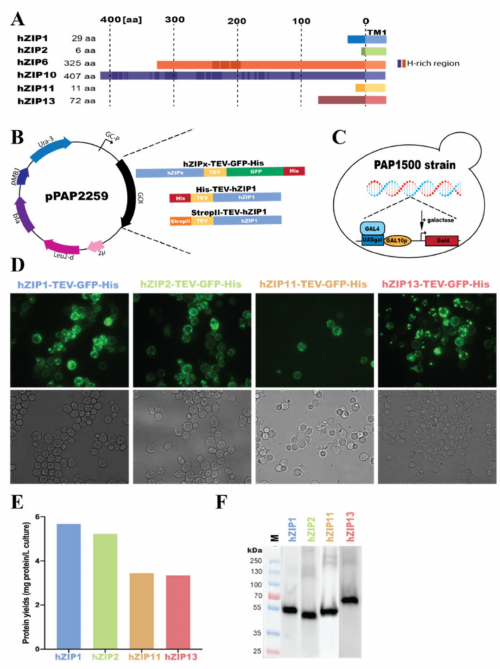
Figure 2. Overproduction of hZIP-TEV-GFP-His fusions in Saccharomyces cerevisiae -based system. ( A ) Generalized domain structure of the N-termini of human ZIP targets approached in this study, including the four shortest and the two longest human ZIPs. N-terminal segments of hZIP1 (Q9NY26), hZIP2 (Q9NP94), hZIP6 (Q13433), hZIP10 (Q9ULF5), hZIP11 (Q8N1S5), and hZIP13 (Q96H72) were assigned using TOPCONS topology prediction tool (http://topcons.cbr.su.se) [50]. UniProt (https://www.uniprot.org/) [51] accession numbers of full-length hZIPs protein sequences are shown in brackets. The length of the N-termini, and the positions of histidine-(H)-rich regions (dark boxes) and transmembrane segments TM1 are indicated. ( B ) Map of the S. cerevisiae expression plasmid pPAP2259 encoding the different hZIP genes of interest (GOIs) used in the study shown in order of their appearance. Expression constructs were designed to include the full-length forms of the respective hZIPs and different combinations of the following elements: tobacco etch virus (TEV) protease cleavage site, green fluorescent protein (GFP), an octa-histidine- (His) or a StrepII-tag (StrepII). The arrangement of regions of the respective constructs are shown. The expression plasmid also contains a hybrid promotor with the GAL10 upstream activation sequence in the 5 (cid:48) nontranslated leader of the cytochrome-1 gene (CG-P), a yeast origin of replication (2 µ ), a β -isopropylmalate dehydrogenase gene with truncated promotor sequence resulting in poor expression of this gene ( leu2-d ), a β -lactamase gene ( bla ), an origin of replication (pMB1), and a yeast orothidine-5-phosphate decarboxylase gene ( URA3 ). ( C ) The S. cerevisiae protein production strain PAP1500 used in the study. Upon induction with galactose, the strain overexpresses the Gal4 transcriptional activator that is the limiting factor for expression from galactose regulated promoter. GAL10p and UASgal constitute a specific DNA binding site for GAL4 activator. ( D ) Live-cell bioimaging of S. cerevisiae cells (derived from 2-L cultures) expressing hZIP1-, hZIP2-, and hZIP13-TEV-GFP-His (72-h induction at 15 ◦ C) or hZIP11-TEV-GFP-His (48-h induction at 15 ◦ C). For each construct GFP fluorescence (top) and differential interference contrast (bottom) micrographs are shown. Magnification: 1000 × . ( E ) Estimates of protein production levels of four selected hZIPs expressed as in ( D ). The intensity of the whole-cell GFP fluorescence signal was transformed to the protein amount, by comparison against a free-GFP standard curve fluorescence signal, and the predicted yield is expressed as mg per L of cell culture. ( F ) In-gel GFP fluorescence of SDS-PAGE-resolved whole-cell lysates (i.e., supernatant from centrifuged homogenates) expressing different hZIP-TEV-GFP-His fusions as in ( D ). The predicted MWs of the respective fusions are 63.3 kDa (hZIP1), 61.8 kDa (hZIP2), 63.8 kDa (hZIP11), and 68 kDa (hZIP13). M: